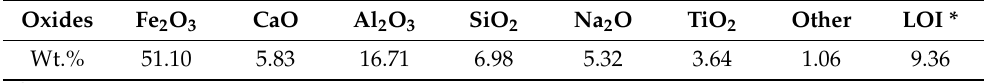
Table 1. The chemical composition of red mud, determined by XRF analysis and expressed as % oxide.